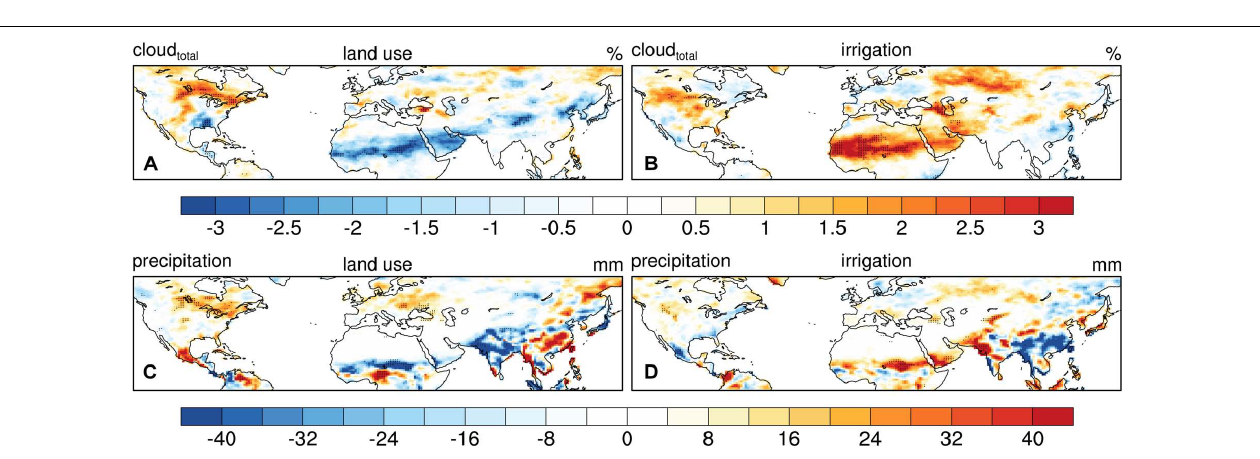
FIGURE 5 | Changes in summer nighttime latent heat [LE in W/m 2 , (A,B) ], sensible heat [H in W/m 2 , (C,D) ], and ground heat [G in W/m 2 , (E,F) ] fluxes due to historical land use (left) and irrigation (right). Stippling indicates significance at the 95% confidence level.